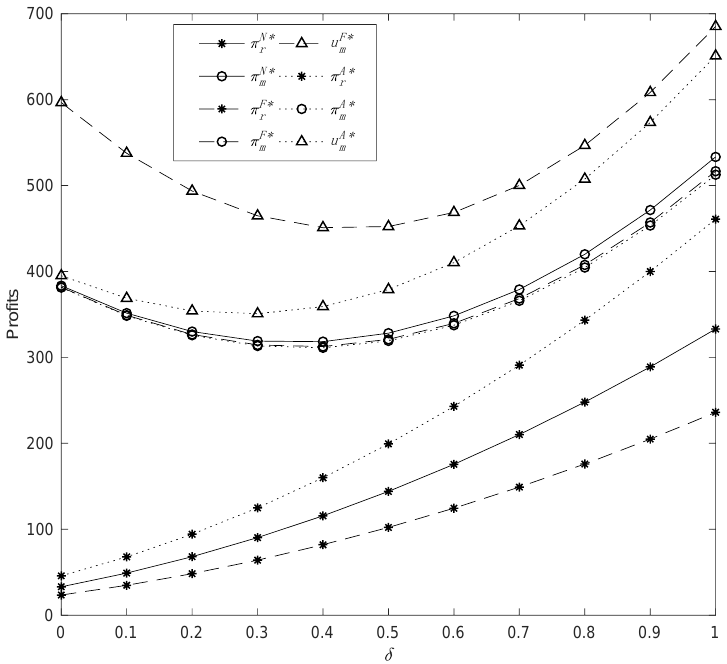
Figure 4. The change in profits with parameter δ.